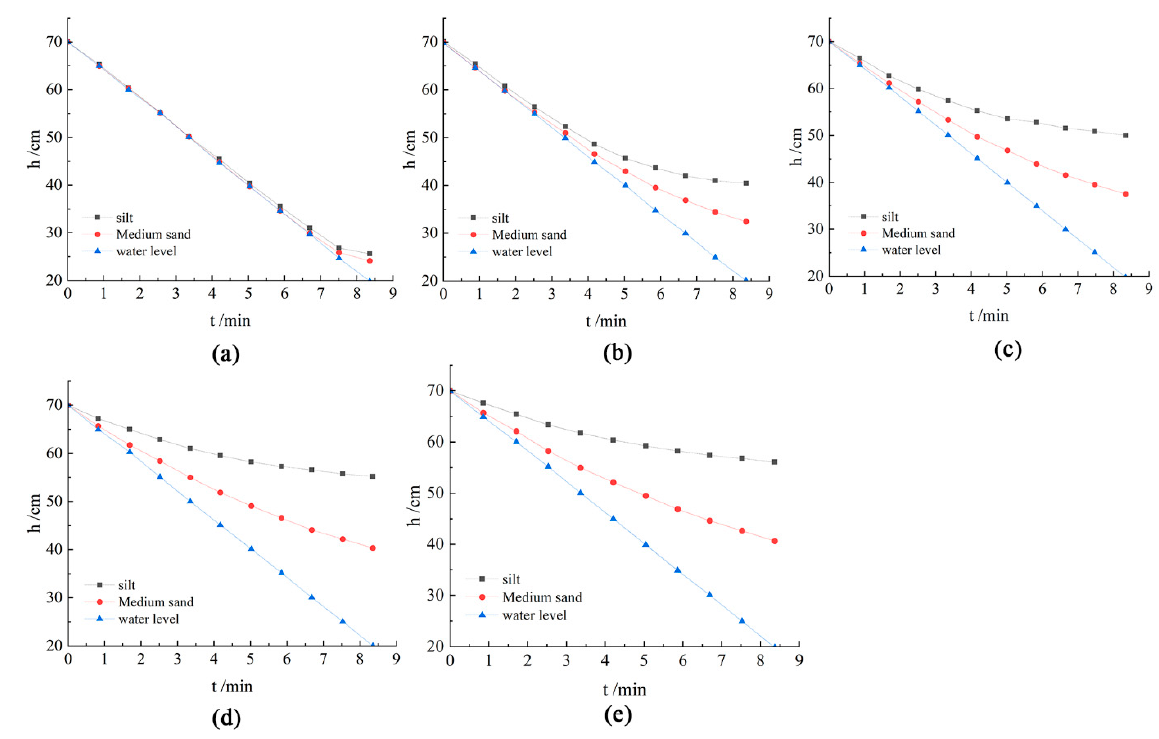
Figure 12. Variation of pore pressure at different points in slopes with different materials: ( a ) x = 100 cm; ( b ) x = 140 cm; ( c ) x = 180 cm; ( d ) x = 220 cm; and ( e ) x = 250 cm.